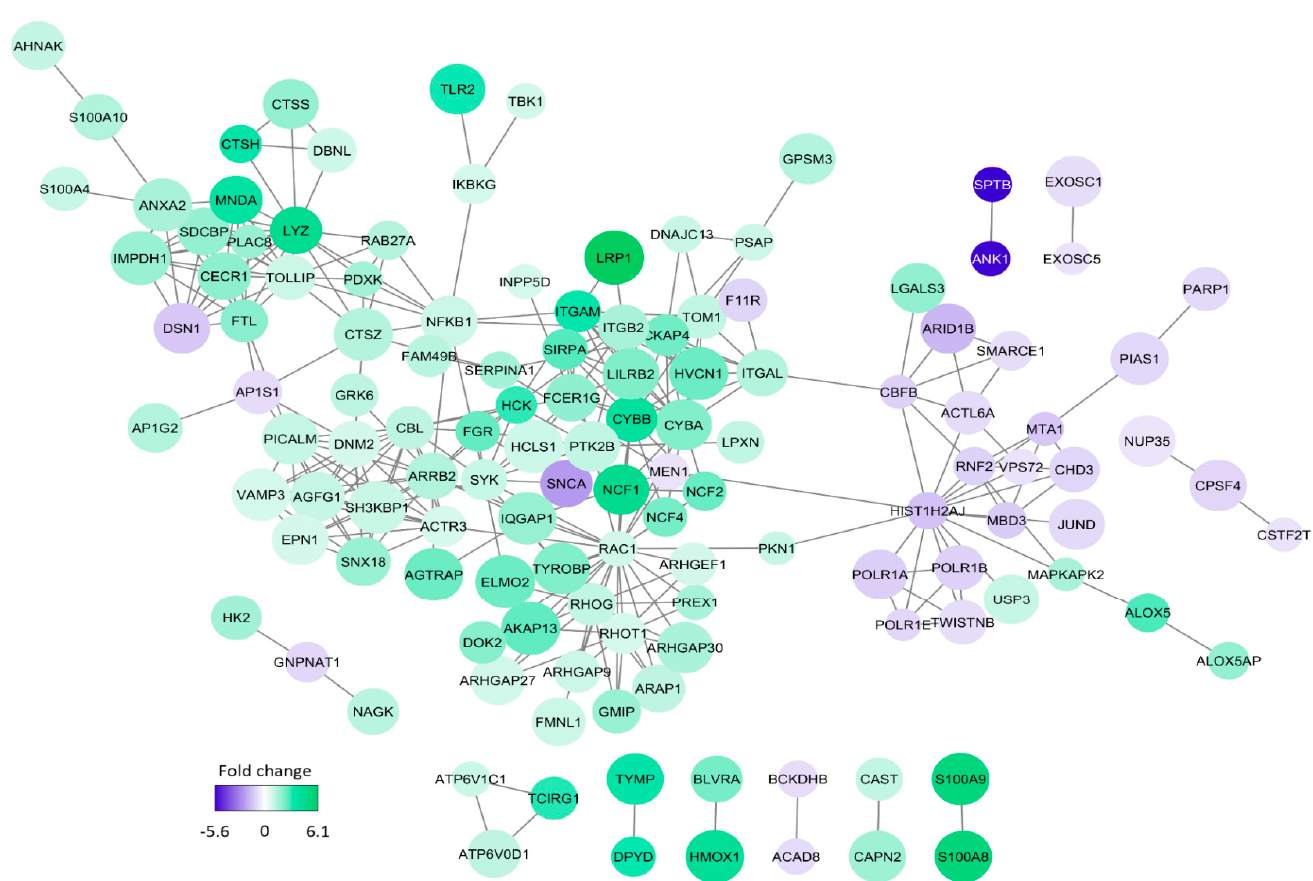
Figure 5. The network analysis of proteins showing differential expression in primary AML cells with generally high versus generally low constitutive release of extracellular mediators. The intensity of the color reflects the fold change (FC) significance when comparing the high- and low-release groups; thus a negative fold change indicates increased protein abundance in the low-release group (purple) and a positive fold change indicates increased protein abundance in the high-release group (green). This STRING-DB analysis was based only on the 256 proteins that were quantified and considered significantly different between the two groups; the figure thus shows proteins from our quantified data and no shells of interactors were considered.